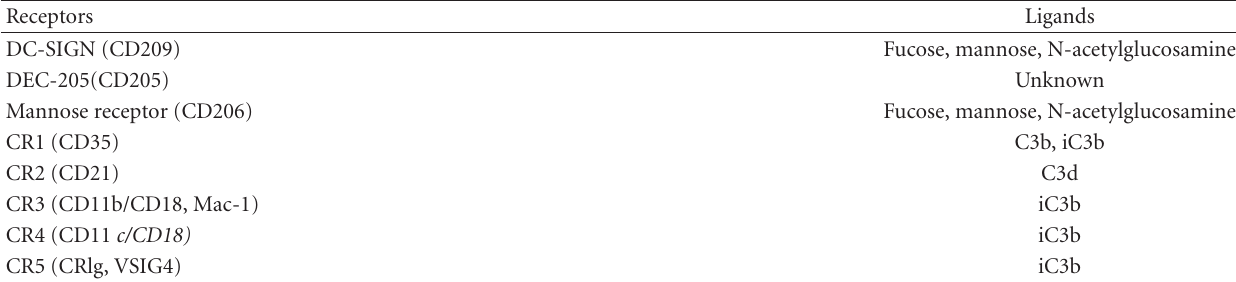
Table 1: Lectin-like receptors, complement receptors (CR), and